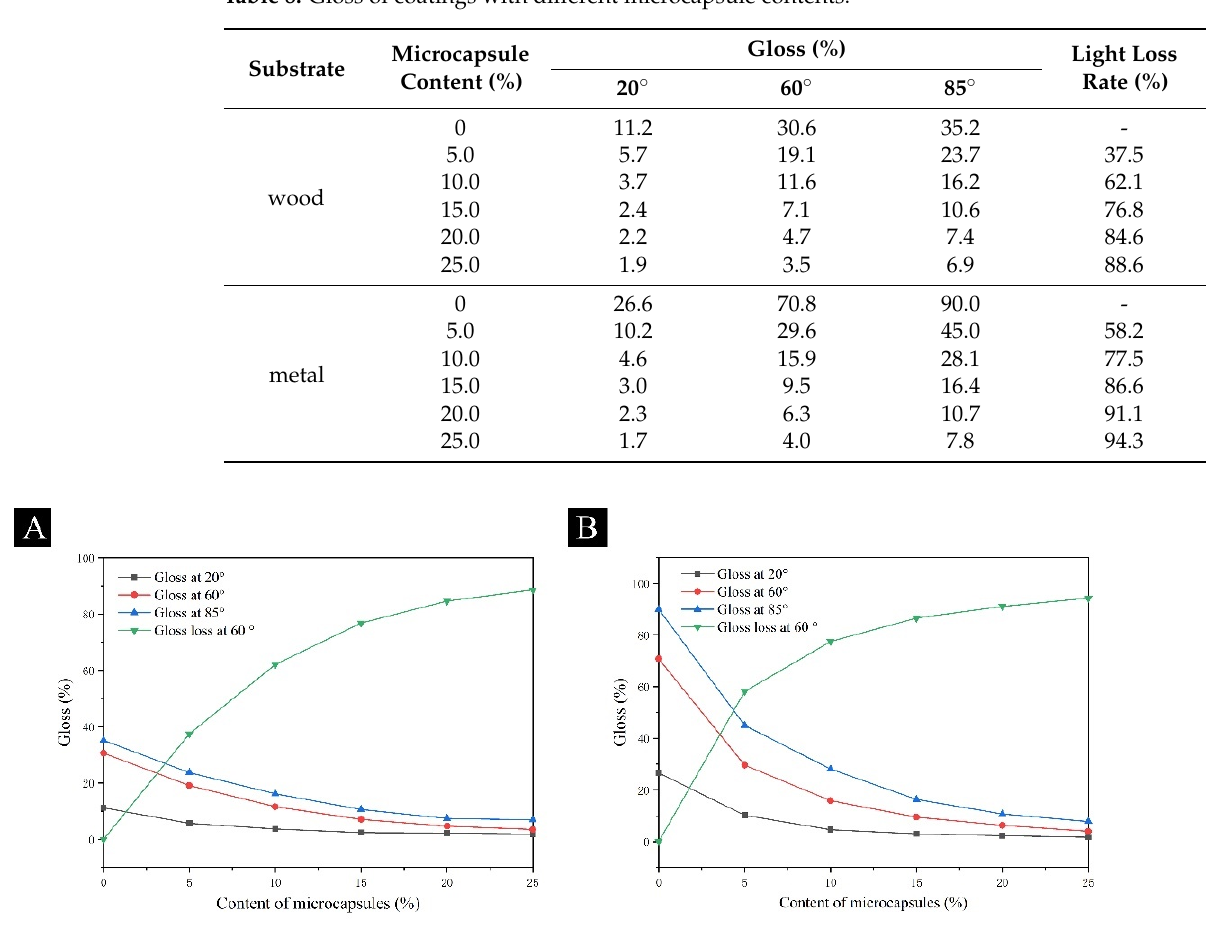
Table 8. Gloss of coatings with different microcapsule contents.